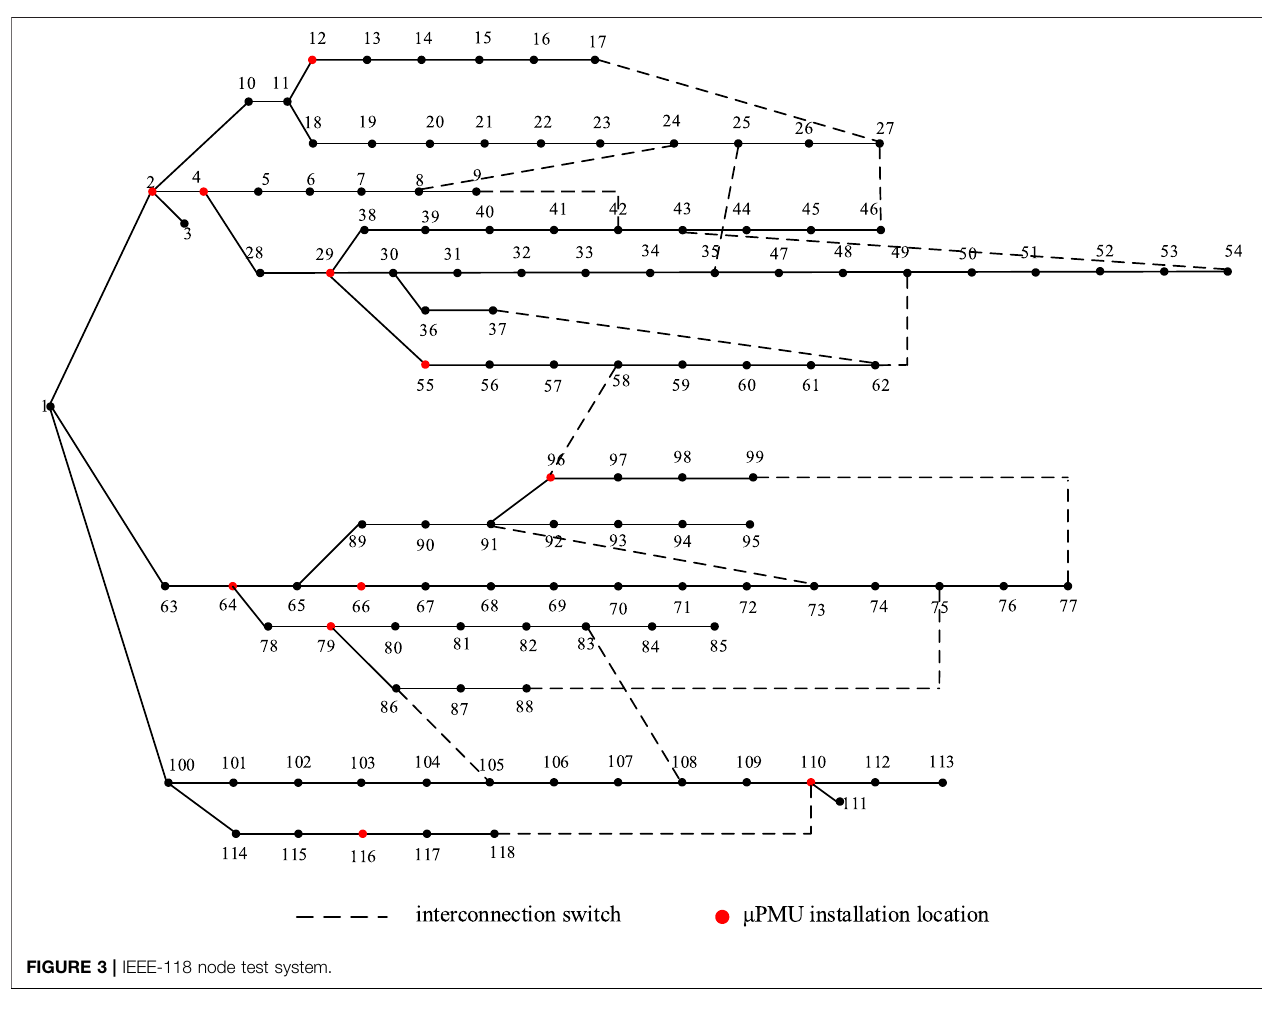
FIGURE 3 | IEEE-118 node test system.